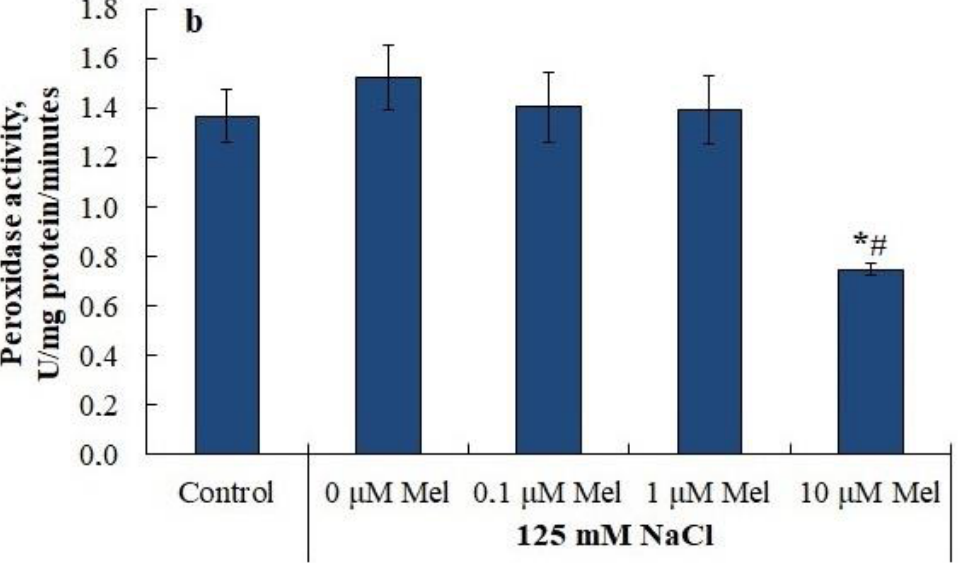
Figure 6. Influence of melatonin and chloride salinity on the activity of antioxidant enzymes: ( a ) Superoxide dismutase (SOD) activity; ( b ) Peroxidase activity. Asterisks (*) indicate significant differences from the control variant and the «#» indicates significant differences from the «125 mM NaCl» variant ( p < 0.05).